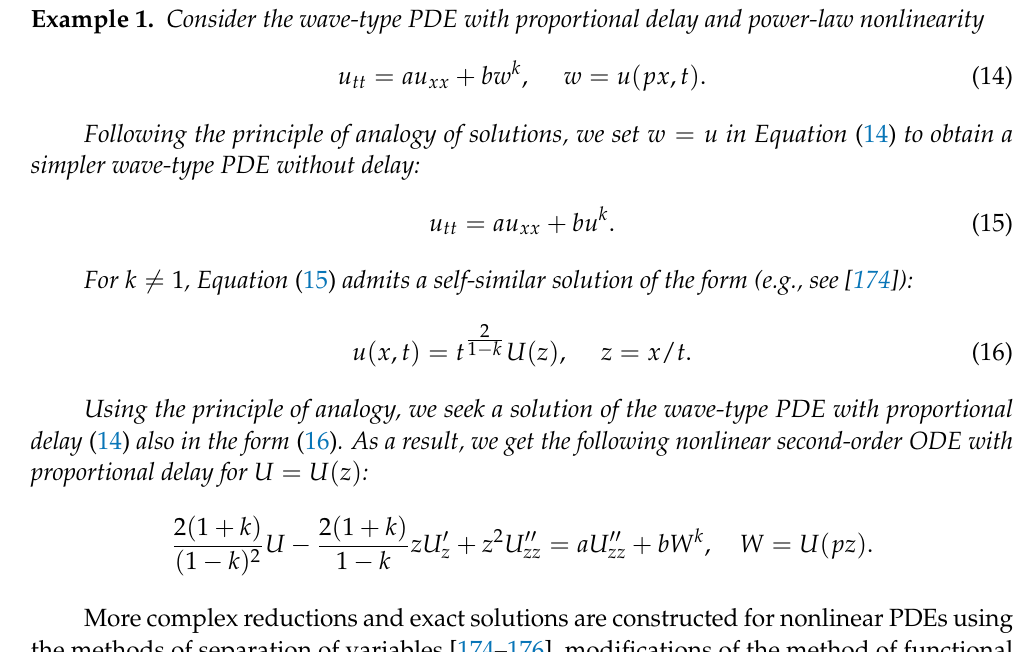
Figure 1. A schematic of using the principle of analogy to construct exact solutions for nonlinear wave-type PDEs with proportional